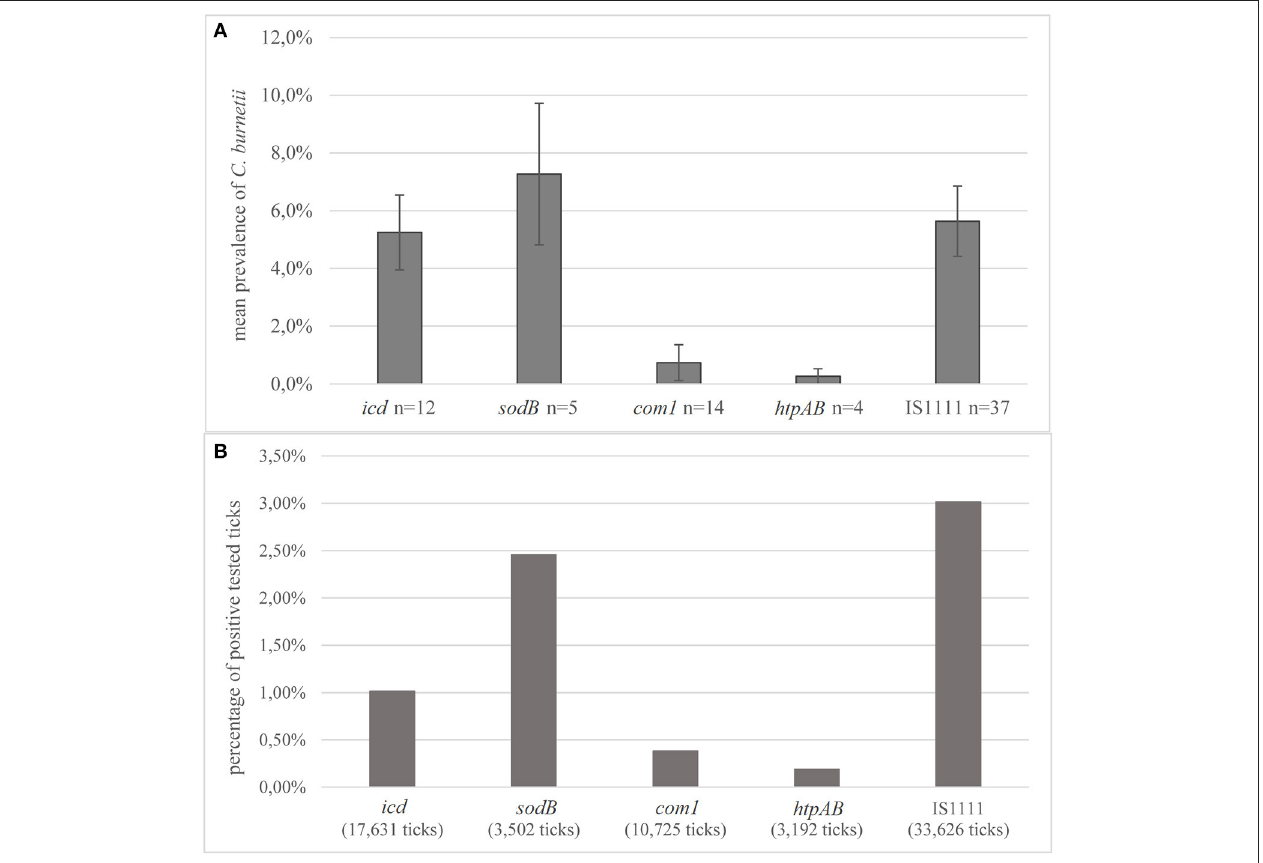
FIGURE 5 | Detection methods (A) average prevalence of C. burnetii in PCR detection depending on the target genes. Error bars show average confidence intervals. n = number of studies; (B) percentage of positively tested ticks of the total number of tested ticks in all studies, depending on the detection method. In two studies, 567 ticks were collected from humans and tested negative. Number in parentheses = total number of ticks tested with this method.